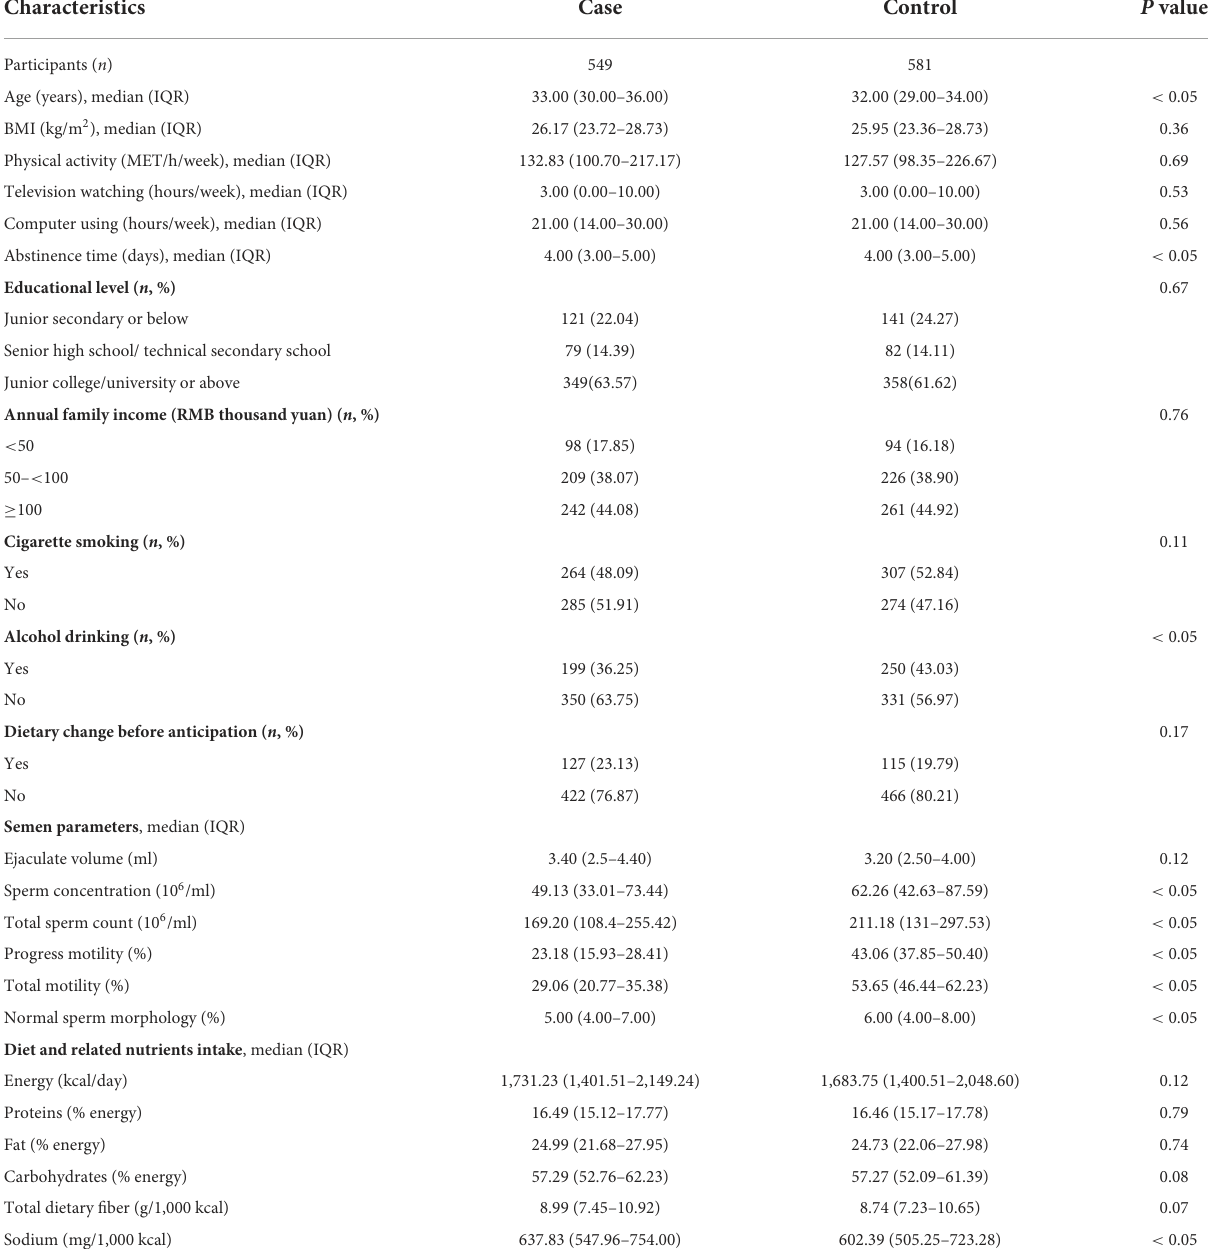
TABLE 1 General characteristics of